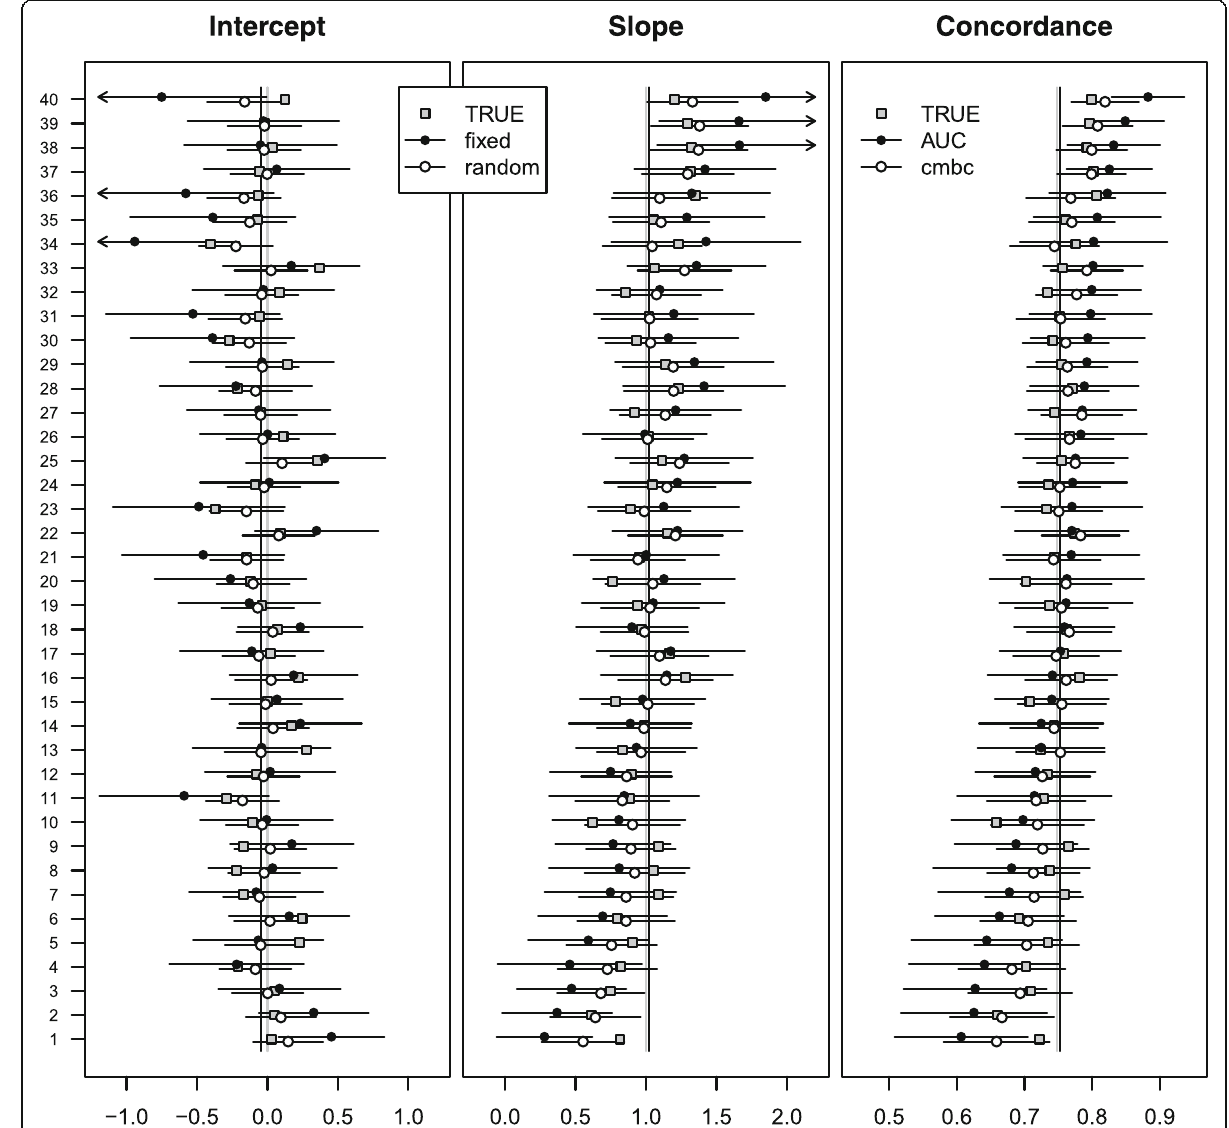
Fig. 3 Performance measures across 40 centers of 200 simulated patients. Gray squares represent true values of intercept, slope, and concordance probability. Closed dots represent fixed effect intercept estimates; fixed effect slope estimates; and c-indexes in the first, second, and third panel, respectively. Open dots represent random effects intercept estimates; random effects slope estimates; and calibrated model-based concordance estimates in the first, second, and third panel, respectively. Gray vertical lines represent effect estimates of intercept and slope in the original regression model, together with the expected pooled concordance. Black vertical lines represent fixed effect estimates of intercept and slope in a multilevel regression model, together with the expected pooled